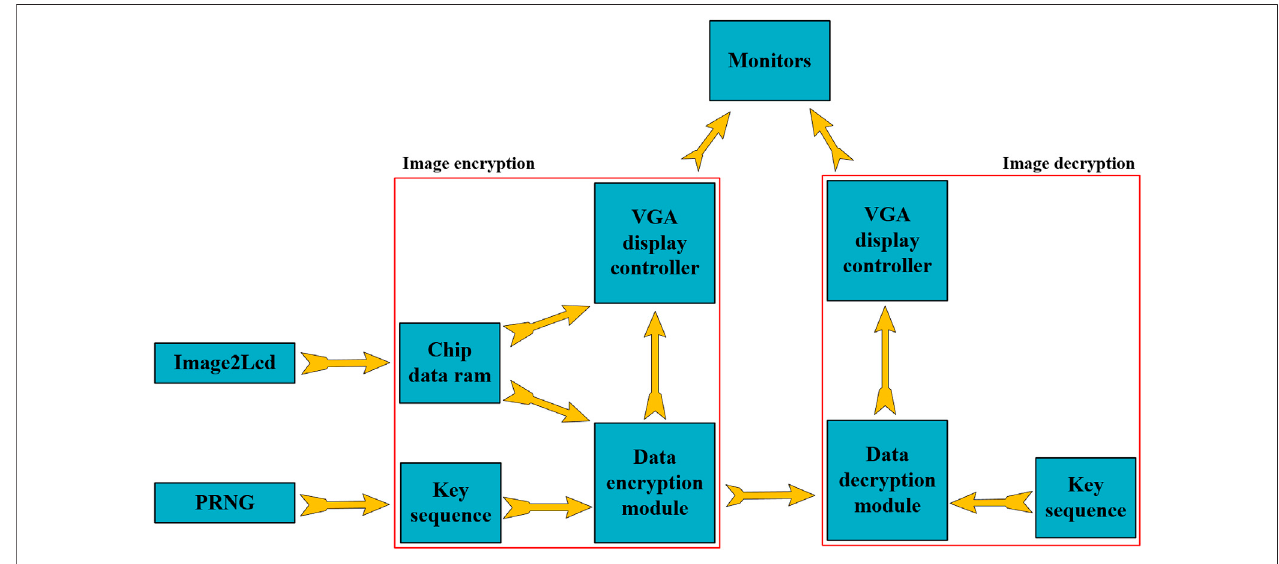
FIGURE 16 | The structure of image encryption and decryption system based on FPGA.